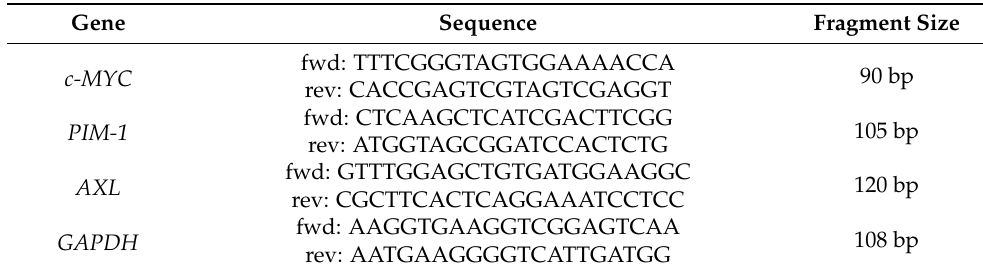
Table 2. Primers used for quantitative real-time